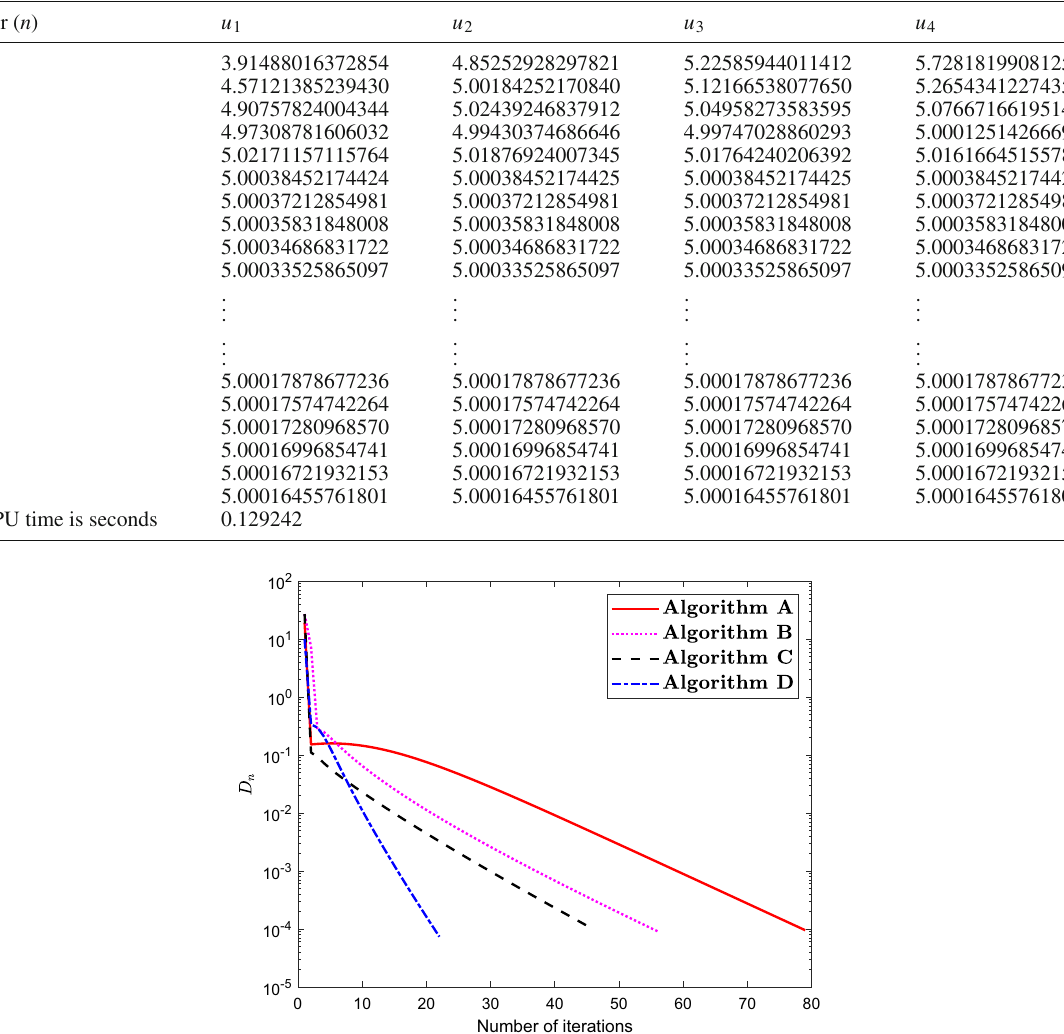
Table 6 Example 4.2: Numerical study of Algorithm 1 and u 0 = u 1 = ( − 3 , − 4 , 1 , − 5 ) T